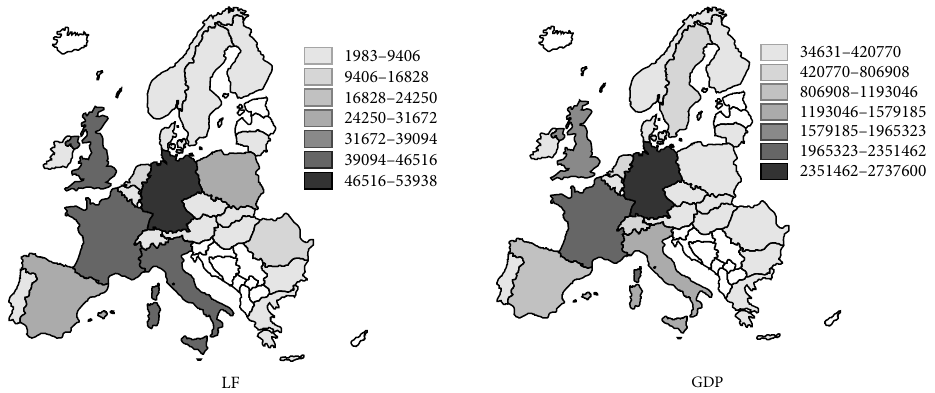
Fig. 8. Labour force in thousands and GDP in market price in millions of